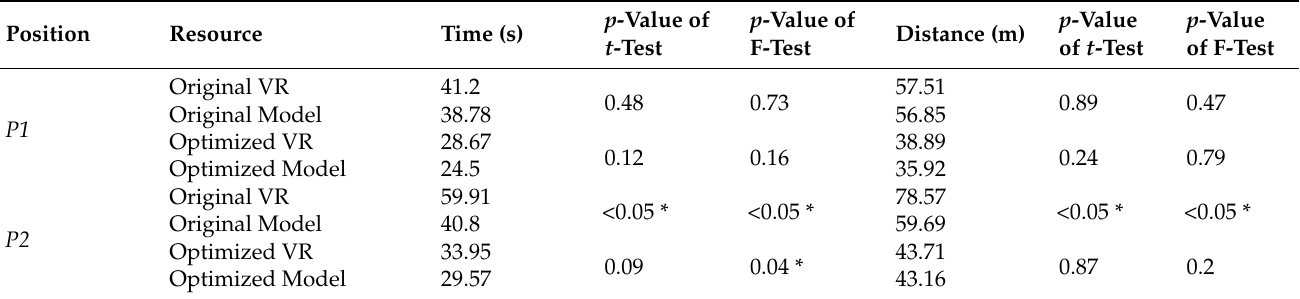
Table 2. Comparison of the time and distance of the VR experiments and the model simulations. Position